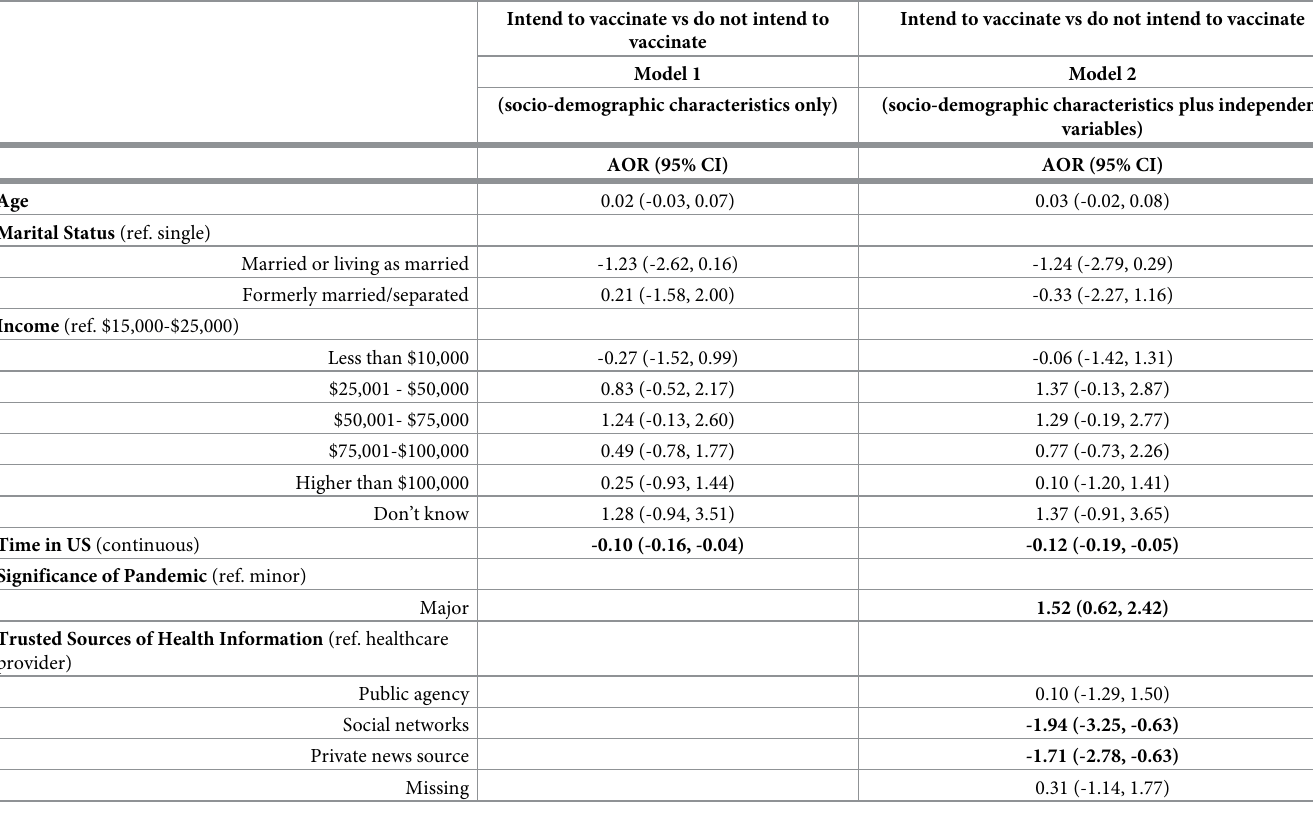
Table 2. Multinomial logistic regression comparing those who did versus those who did not intend to vaccinate (N =